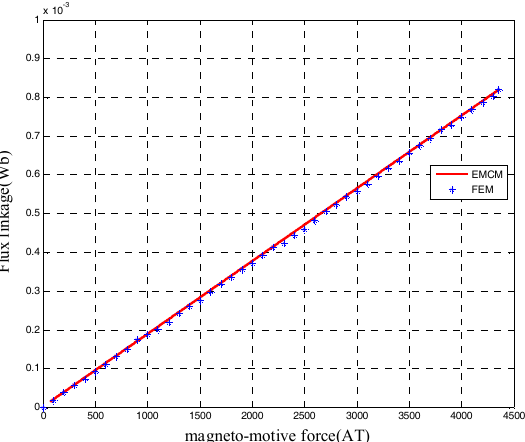
Figure 16. Comparison of flux linkages at completely unaligned position between analytical solution and numerical solution from FEM.